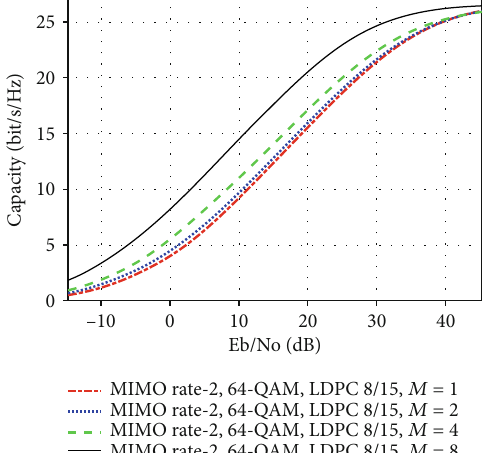
Figure 6: Capacity achieved by various transmitter antennas for a MIMO rate-2 mode with the modulation scheme of 64-QAM and the inner coding of LDPC 8/15.